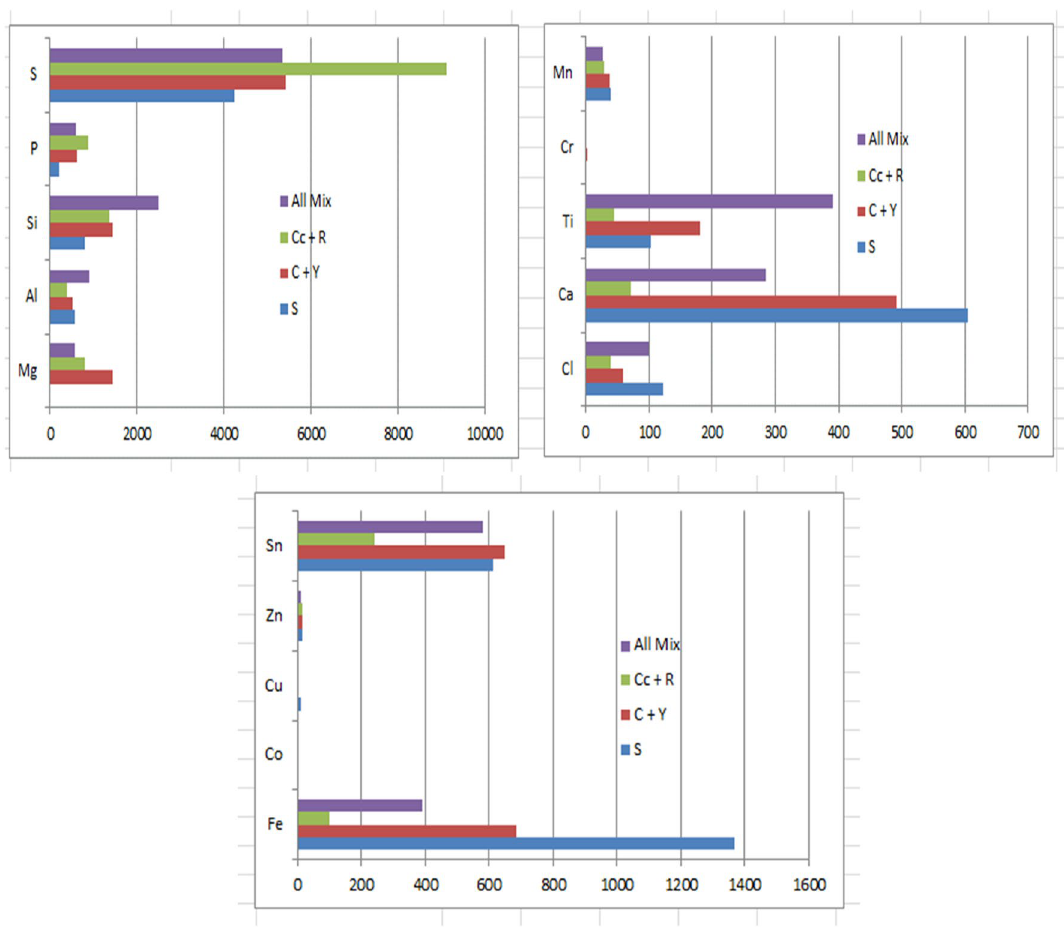
Figure 6. The average elemental composition in sugarcane bagasse, cassava peels + yam peels mixed biomass, corn cobs + rice husks mixed Sbiomass and the mixture of all five biomass